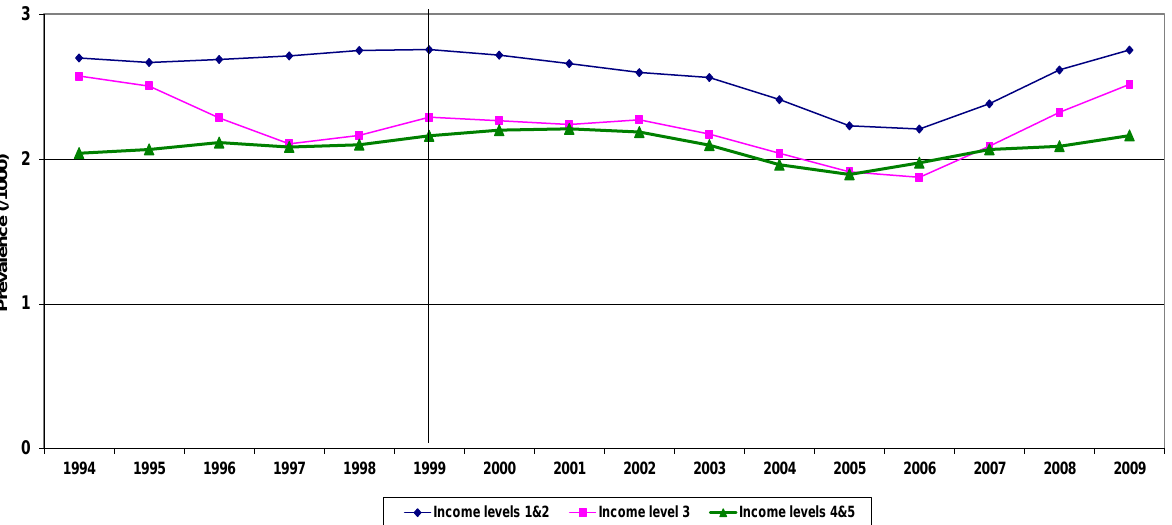
Figure 1. Crude birth prevalence of NTD by income quintiles, Ontario, 1994  2009.